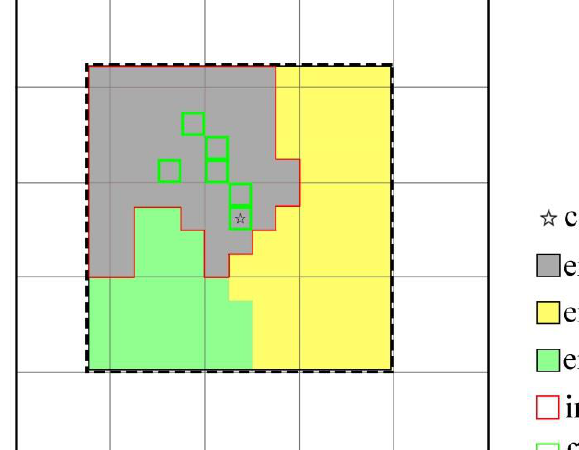
Figure 6. Similar pixel selections.